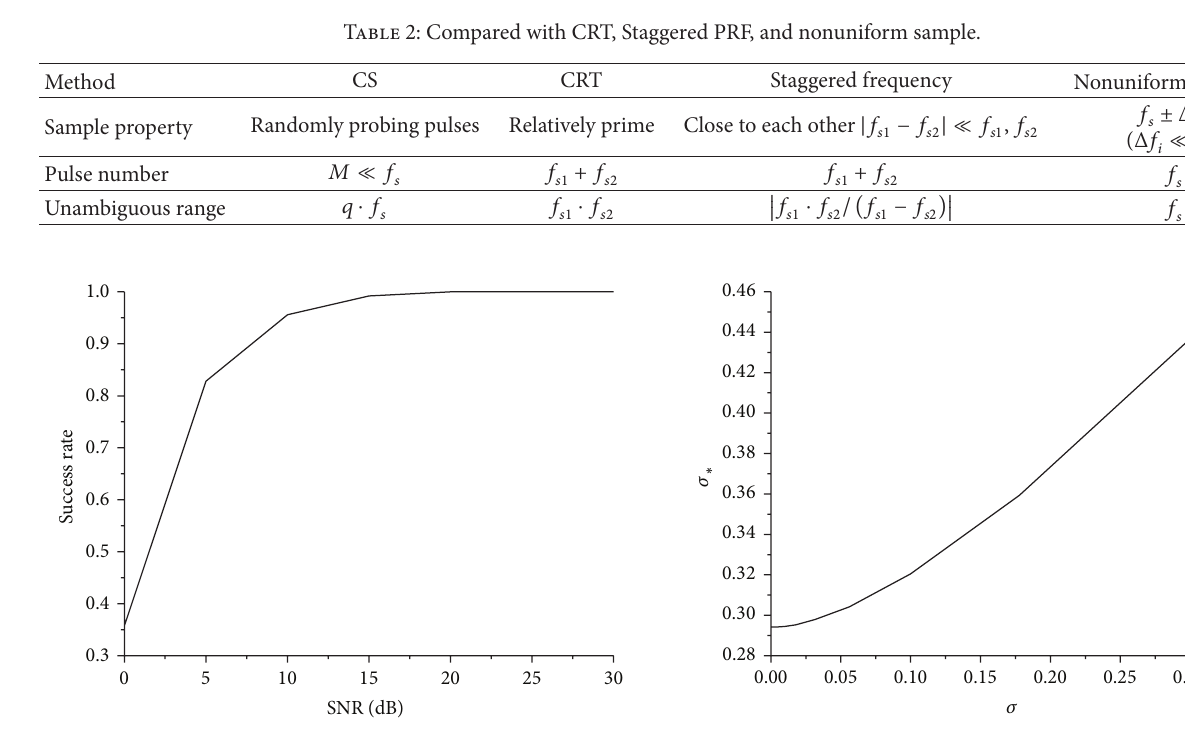
Figure 6: The relationship between 𝜎 and 𝜎 ∗ . The signal amplitude is 1 and the corresponding SNR is set from 10dB to